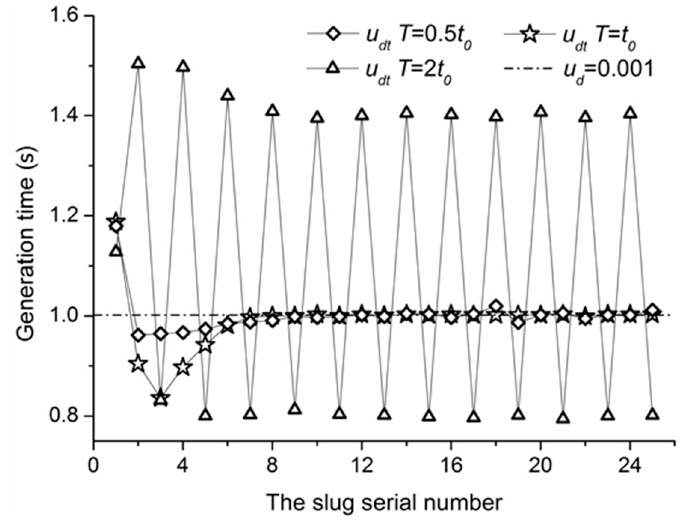
Figure 7. Slug generation time obtained from numerical simulations for a triangle wave dynamic dispersed phase injection flow rate.